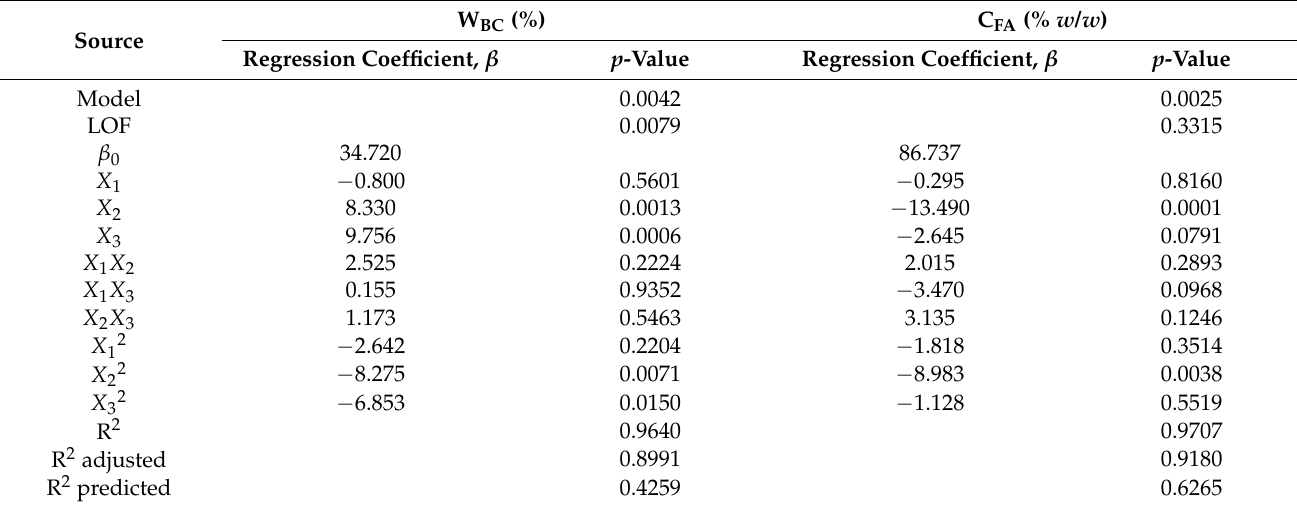
Table 5. Regression coefficients of the full quadratic models with their statistical significance and model parameters for black cumin seed extraction yield (W BC ) and fatty acid content (C FA ).